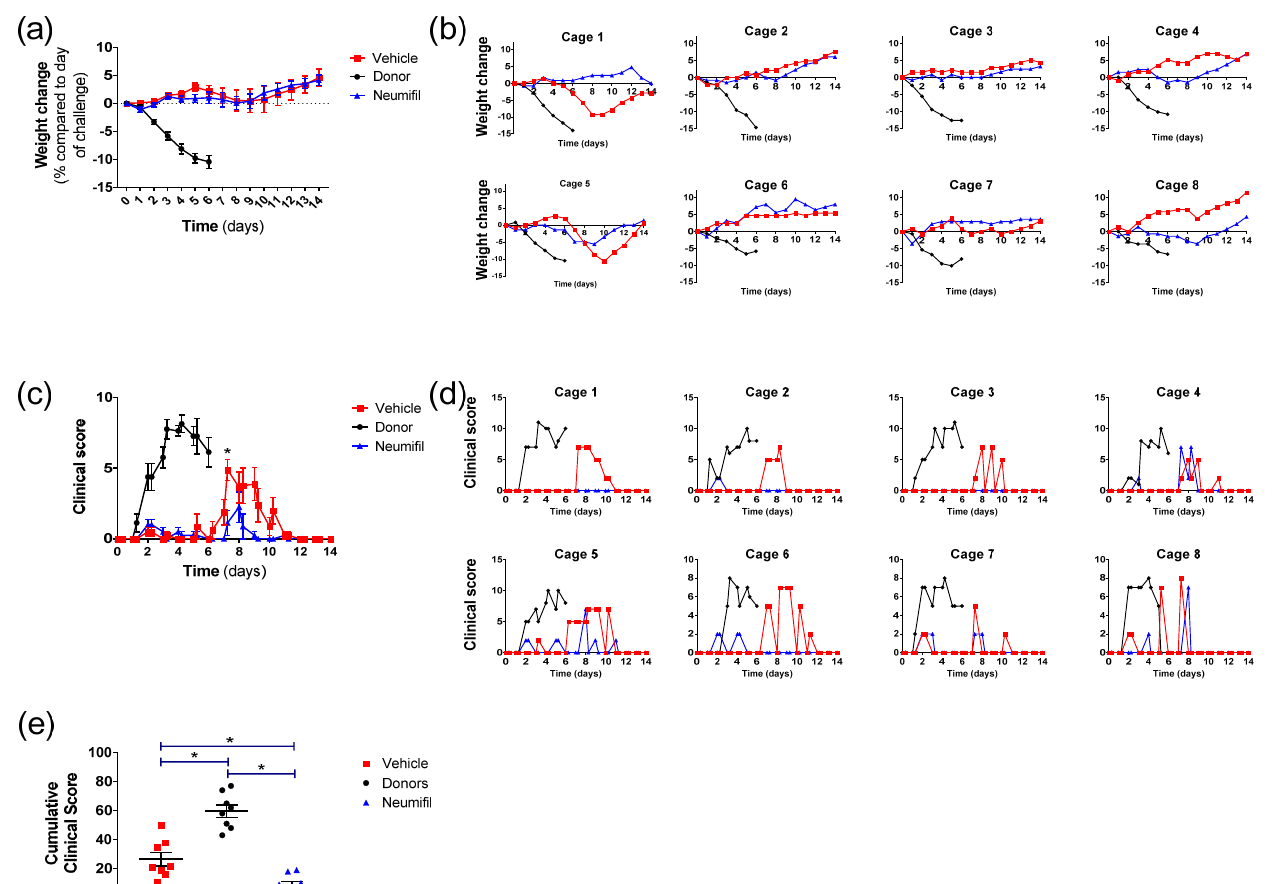
Figure 2. Weight changes and clinical scores in donor animals and recipient animals adjacently housed receiving either Neumifil or vehicle. ( a , b ) Weight change represented as percentage change compared to the day of challenge/study start. ( c , d ) Clinical scores recorded, with each score assigned a numerical value and added to provide a total score for each specific timepoint. ( a , c ) Grouped data from n = 8 animals/group. Lines show mean value with error bars denoting standard error. ( b , c ) Results from each individual animal from each of the eight cage units. ( e ) Cumulative clinical score from all signs recorded throughout the study with each animal represented as a single point. *, p < 0.05.